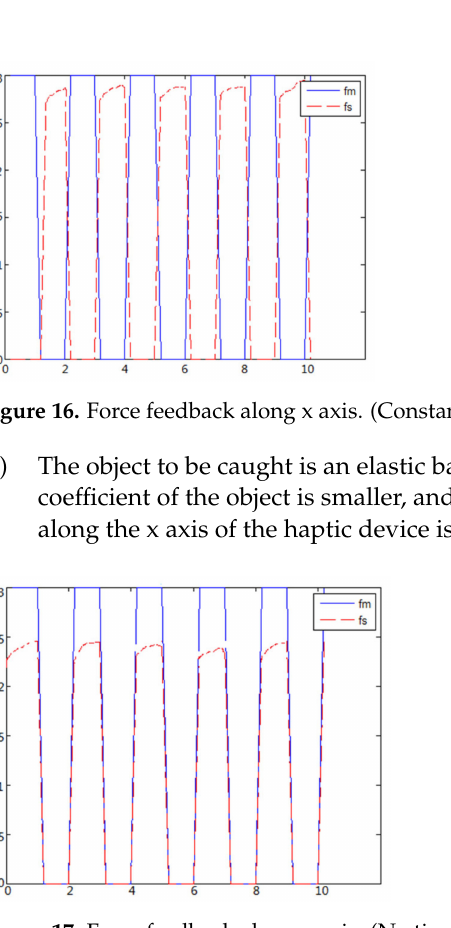
Figure 17. Force feedback along x axis. (No time delay, elastic ball).